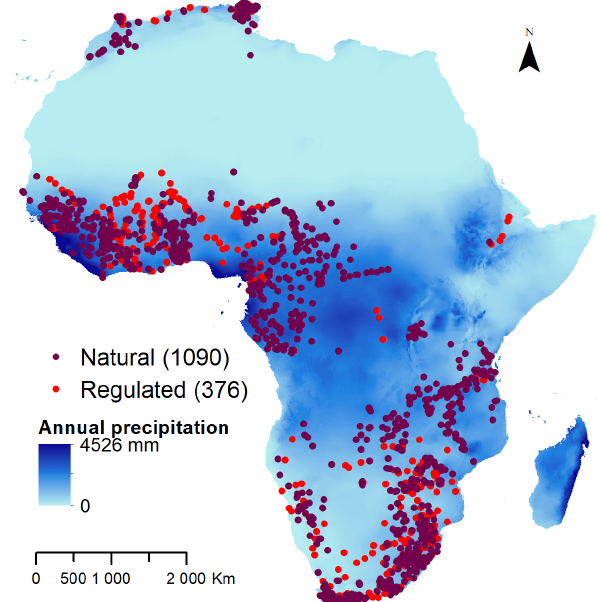
Figure 5. Map of stations with a natural or regulated flow regime. Basins are considered regulated if they contain at least one dam or reservoir from GRanD (Lehner et al., 2011). Mean annual pre- cipitation between 1970 and 2000 is provided from the WorldClim database (Fick and Hijmans,